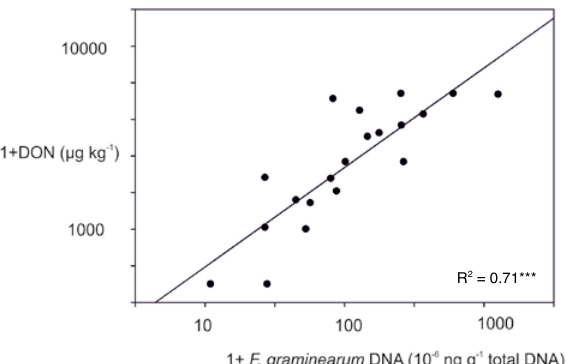
Figure 1. Correlation between log Fusarium graminearum DNA and log deoxynivalenol (DON) concentration in Finnish oat grain samples in 2013. In all samples DON was measured at MTT using accredited GC-MS. DNA was measured either from grain samples ground, at MTT, in a mill with a sieve or from the same grain samples ground with a mill without a sieve, at UTU. Regression slopes and R2 (coefficient of determination) values are shown. * and *** indicate statistically significant ( P <0.05 or 0.001).